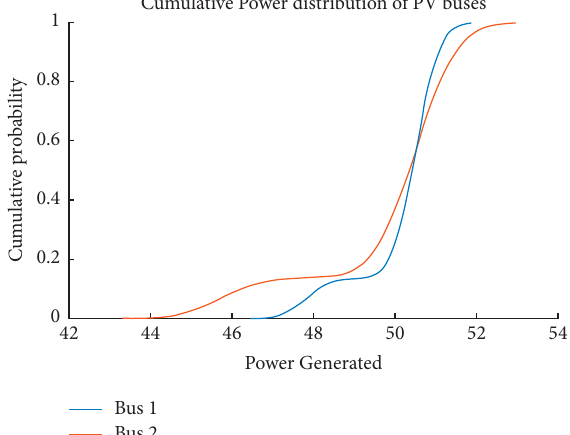
Figure 6: Cumulative power distribution at buses 1 and 2.